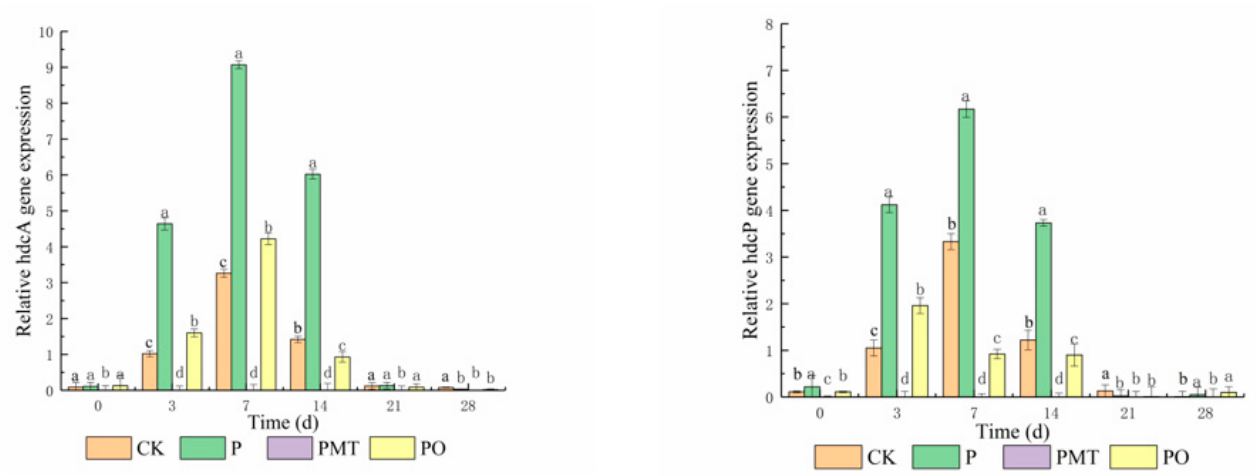
Figure 2. Effect of thyme microcapsules on gene expression of hdcA and hdcP in smoked horsemeat sausage during fermentation and ripening (average ± standard deviation, n = 3). (a–d): Values in the same column and batch not followed by a common letter are significantly different ( p < 0.05) between days. Batch CK: the spontaneously fermented as the control; batch P: inoculated with P. bacillus ; batch PMT: inoculated with P. bacillus and thyme microcapsules; batch PO: inoculated with P. bacillus and essential oil.